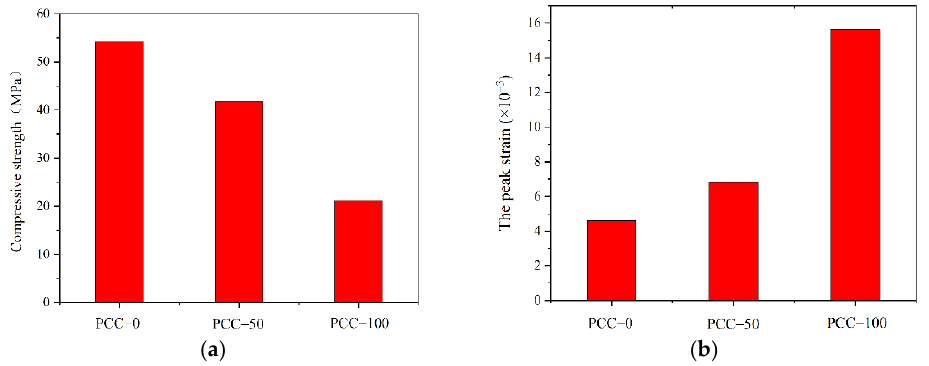
Figure 9. Stress – strain curve of concrete with different substitution amounts of phase change aggre- gates.